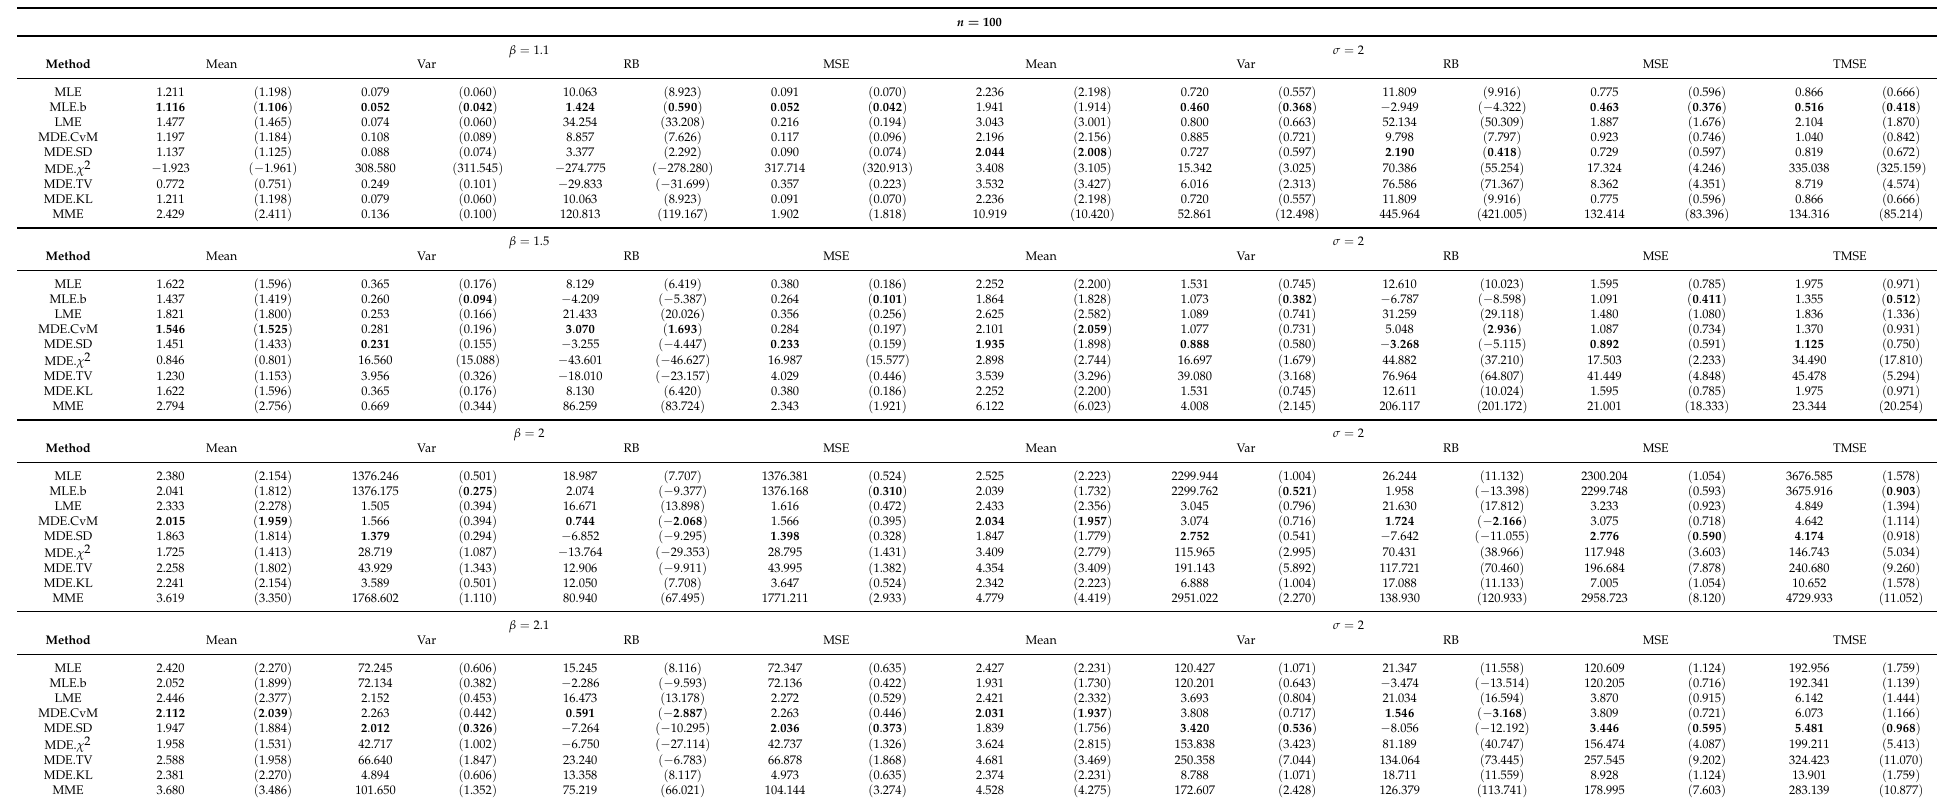
Table A2. Comparison of different estimation methods for different values of β ( σ = 2 and n =